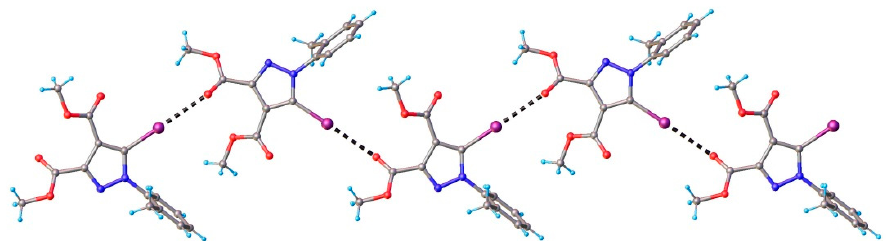
Figure 4. Partial view of the 1D chain formed through C-I ⋯ O halogen bonds in the crystal structure of